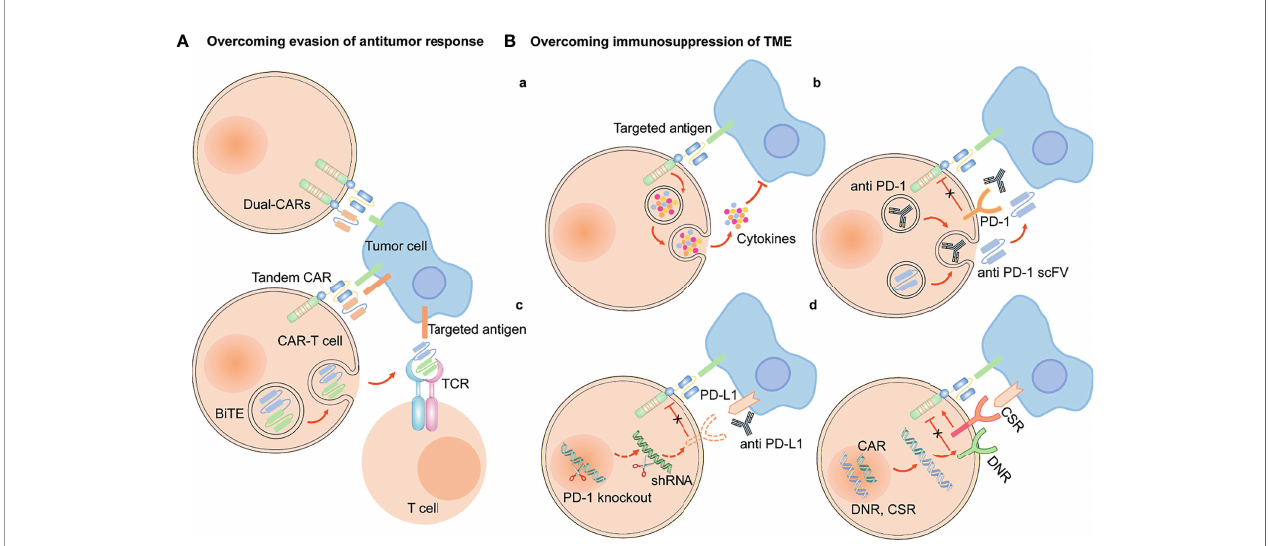
FIGURE 5 | Engineering strategies to overcome evasion of antitumor response and immunosuppression of TME. (A) CAR-T cells are engineered to simultaneously target two antigens (dual CAR-T cells), and secret BiTE to redirect both T cells and CAR-T cells against speci fi c tumor cells and circumvent antigen escape. Tandem CAR-T cells have bispeci fi c receptors, which could target two different antigens. (B) (a) Armored CAR-T cells expressed immunostimulatory cytokines. Approaches to overcoming the immunosuppression of immune checkpoints in TME are as follows, (b) CAR-anti-PD-1/PD-L1 antibodies or scFv, (c) PD-1 gene knockout or downregulation of PD-1 expression by shRNA, (d) express a PD-1 DNR or a PD-1